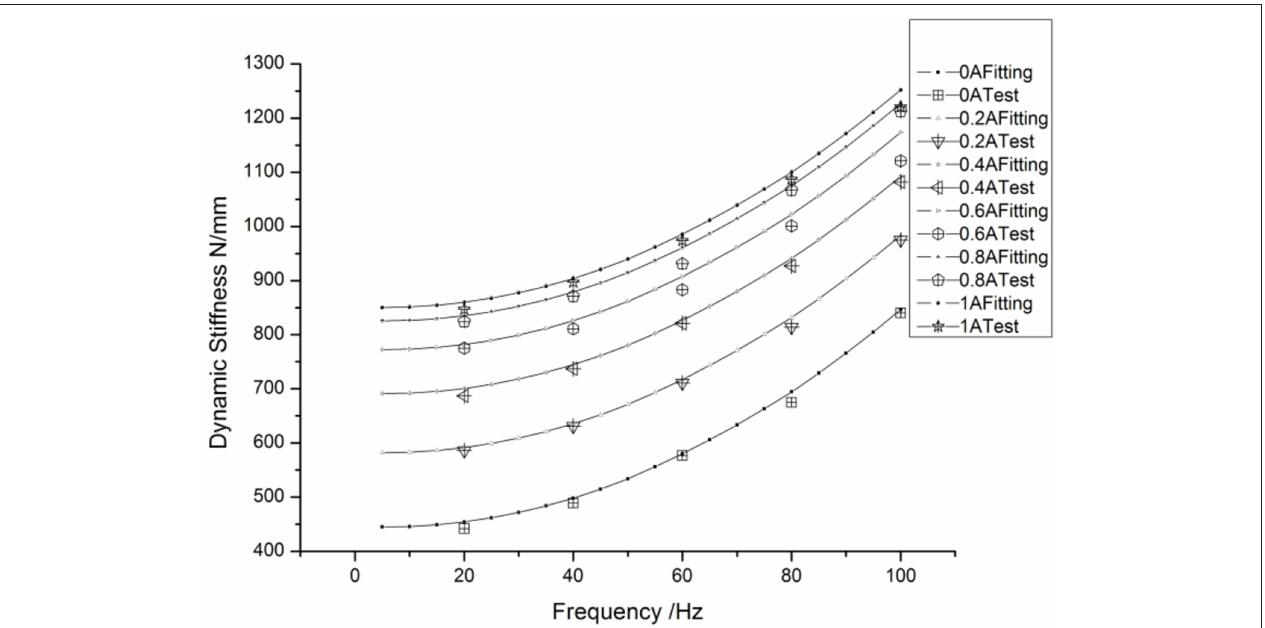
FIGURE 12 | Fitting experiment contrast figure of dynamic stiffness of MR mounts.